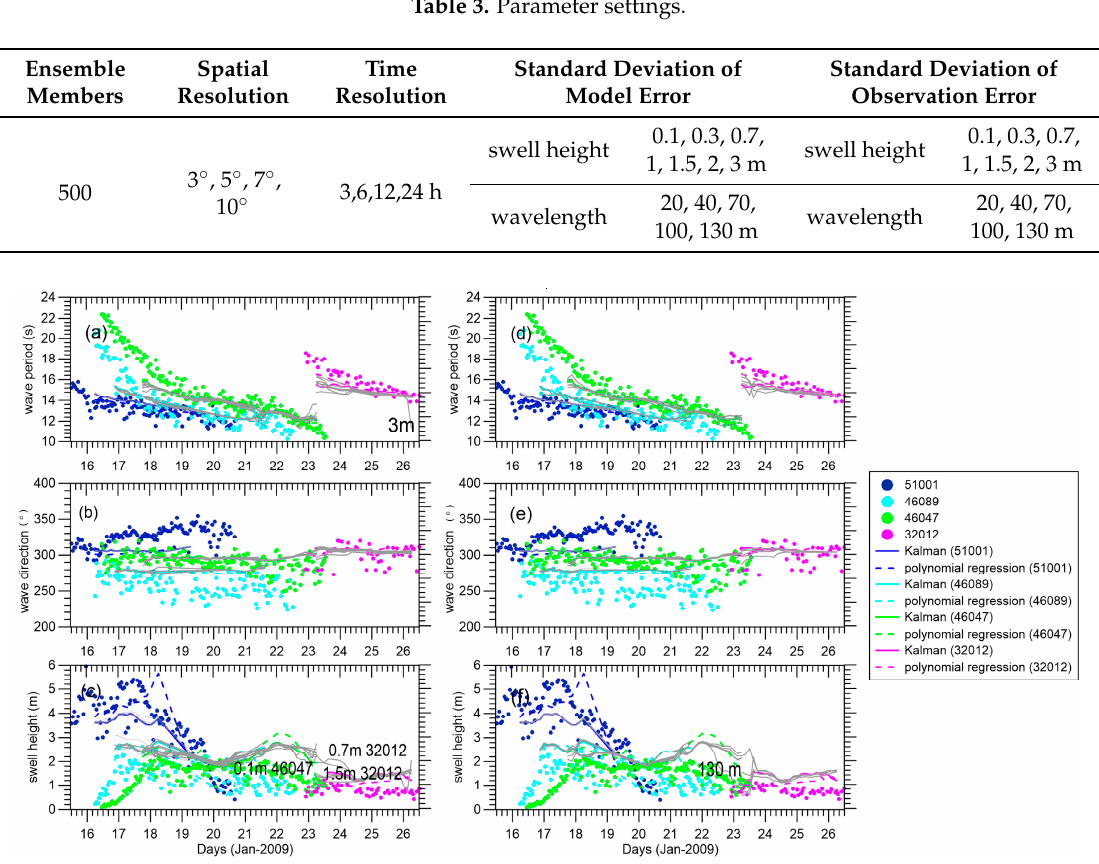
Figure 7. ( a – c ) Gray lines are EnKF results with the swell height measurement error changing